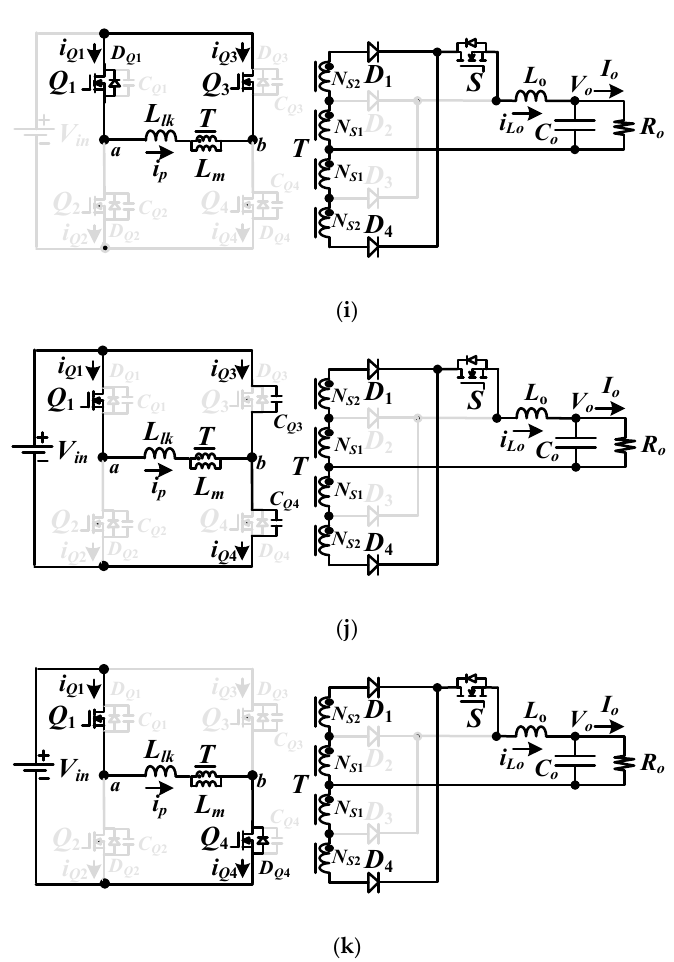
Figure 2. Proposed converter for low input voltage range ( a ) pulse-width modulation waveforms ( b ) mode 1 circuit ( c ) mode 2 circuit ( d ) mode 3 circuit ( e ) mode 4 circuit ( f ) mode 5 circuit ( g ) mode